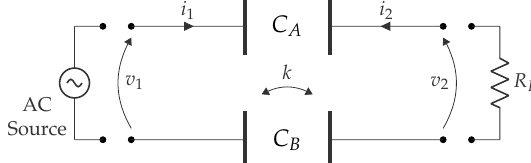
Figure 11. Basic circuit of a capacitive coupled WPT